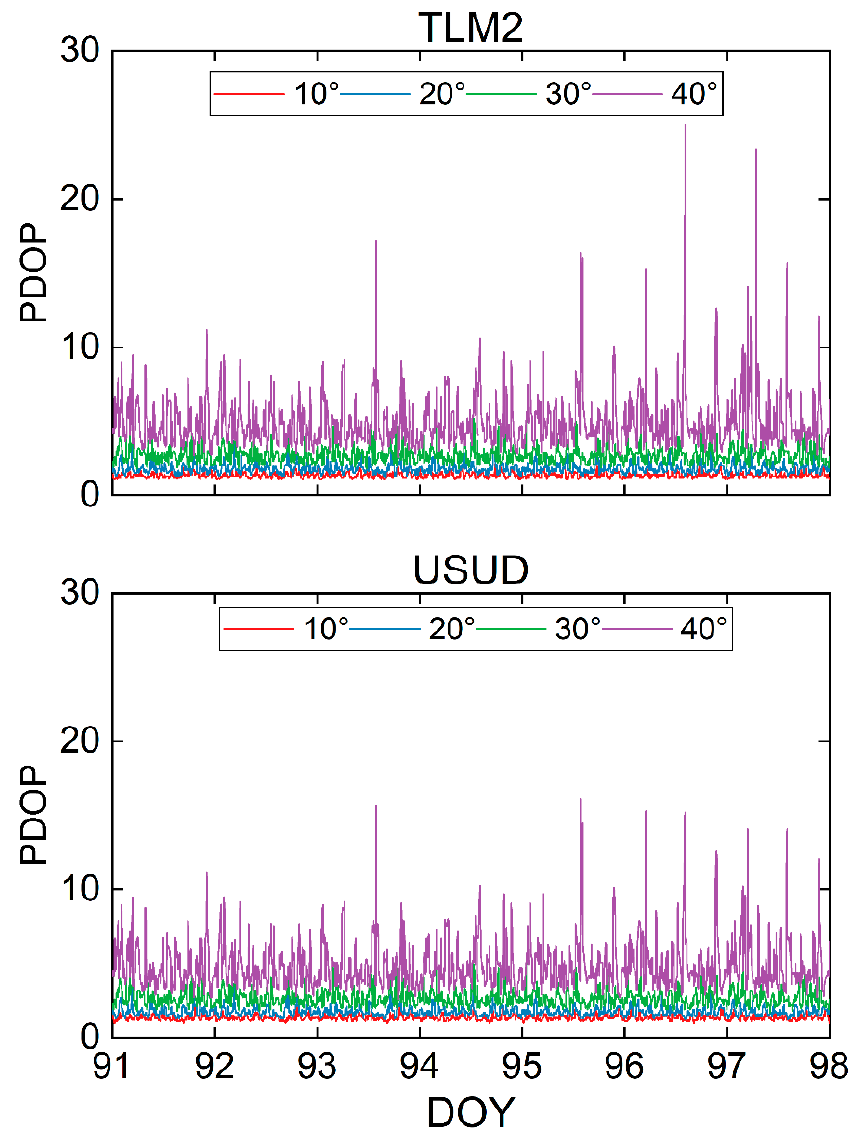
Figure 17. PDOP values of the TLM2 ( top ) and USUD ( bottom ) station.